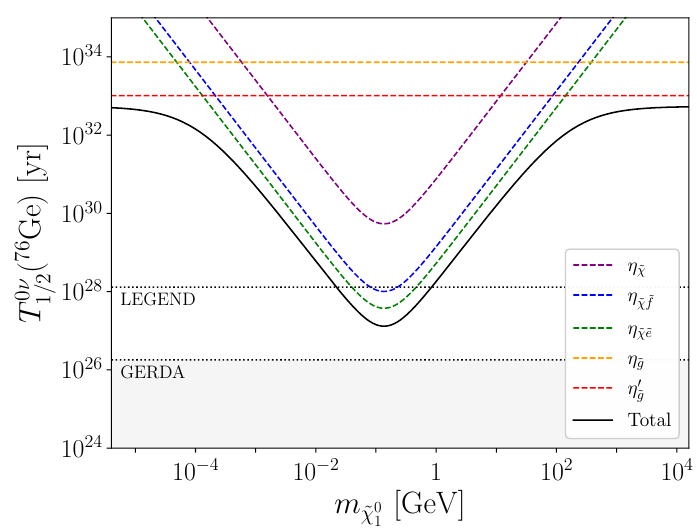
Figure 3 . The contributions of the RPV terms η ˜ χ , η of 76 Ge as a function of the lightest neutralino mass m m ˜ = 2 TeV and m ˜ g = 2 . 5 TeV are chosen for the other MSSM parameters. We compare the d R half-life to the current reach of GERDA [120] and future sensitivity of LEGEND [121], shown by the horizontal dotted